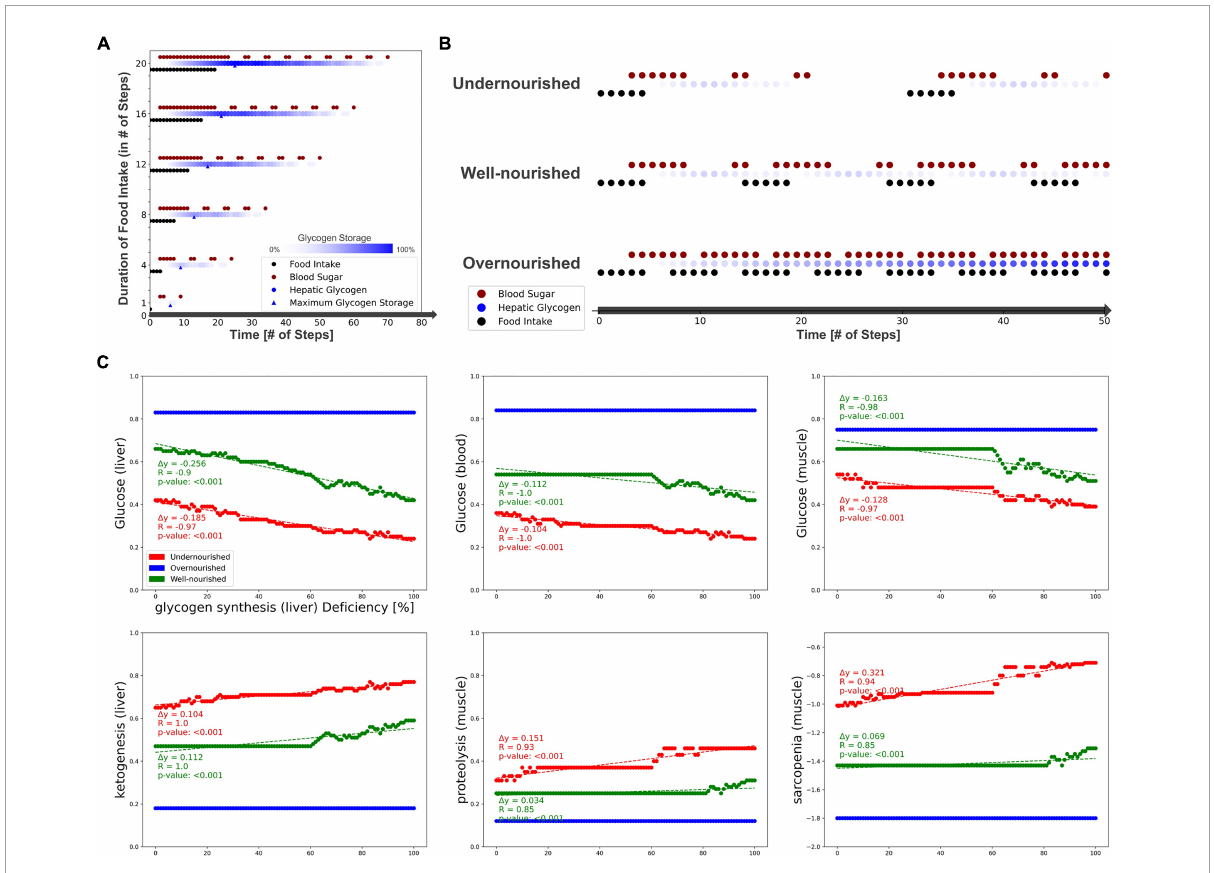
FIGURE5 Testing the model by simulating different nutrition states and carbohydrate availability. (A) The activity of hepatic glycogen storage and extracellular glucose depending on the duration of the food intake stimulus. (B) Definition of three nutrition states by their food intake frequency and the resulting activities of hepatic glycogen storage and extracellular glucose. (C) Predicted activities of selected elements in response to an increasing deficiency of hepatic glycogen